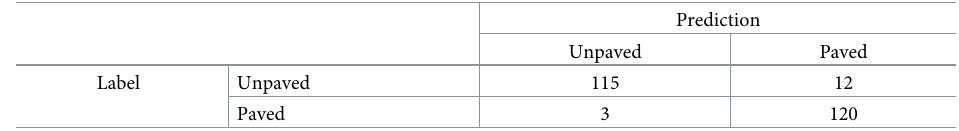
Table 4. Nigeria results. Label Unpaved 115 Paved 3 120 Confusion matrix for the 250 Nigerian roads